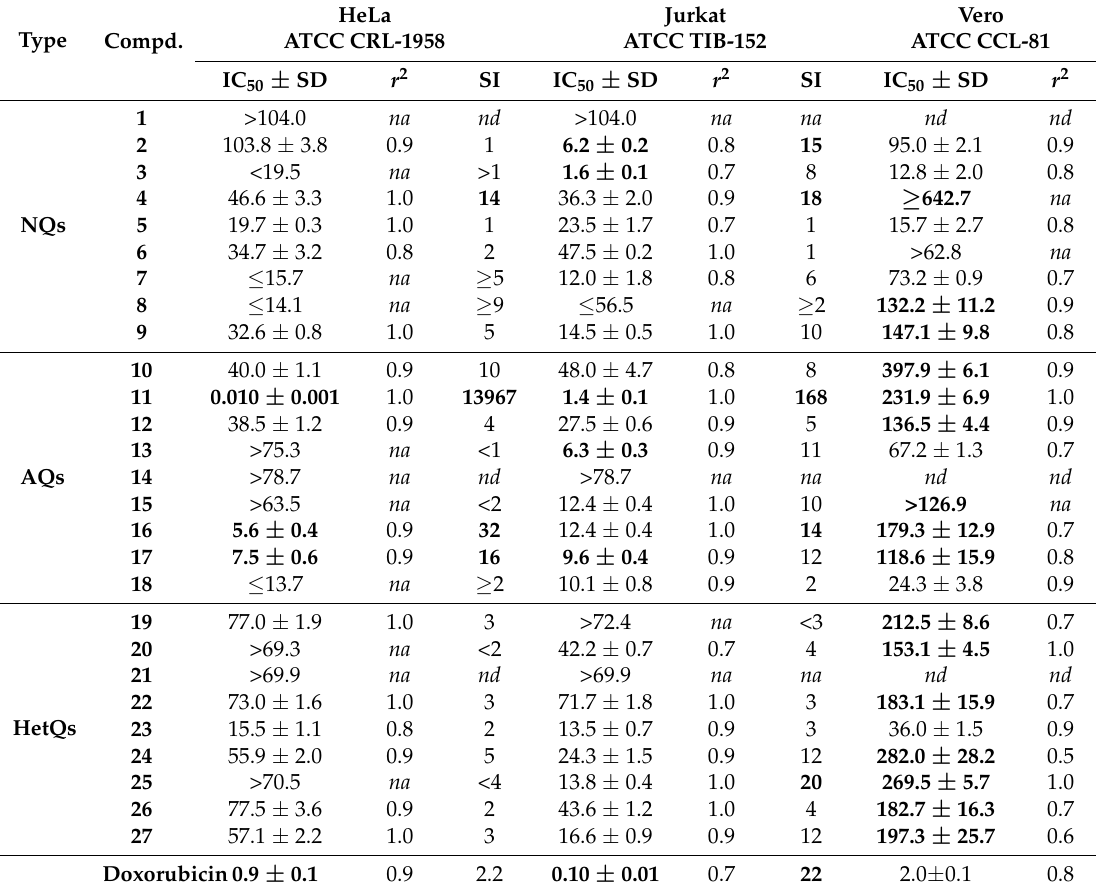
Table 3. Cytotoxicity results (IC 50 , µ M) of 1,4-naphthoquinones (NQs), 1,4-anthraquinones (AQs) and heterocycle-fused quinones (HetQs) on HeLa, Jurkat and Vero cell lines after 48